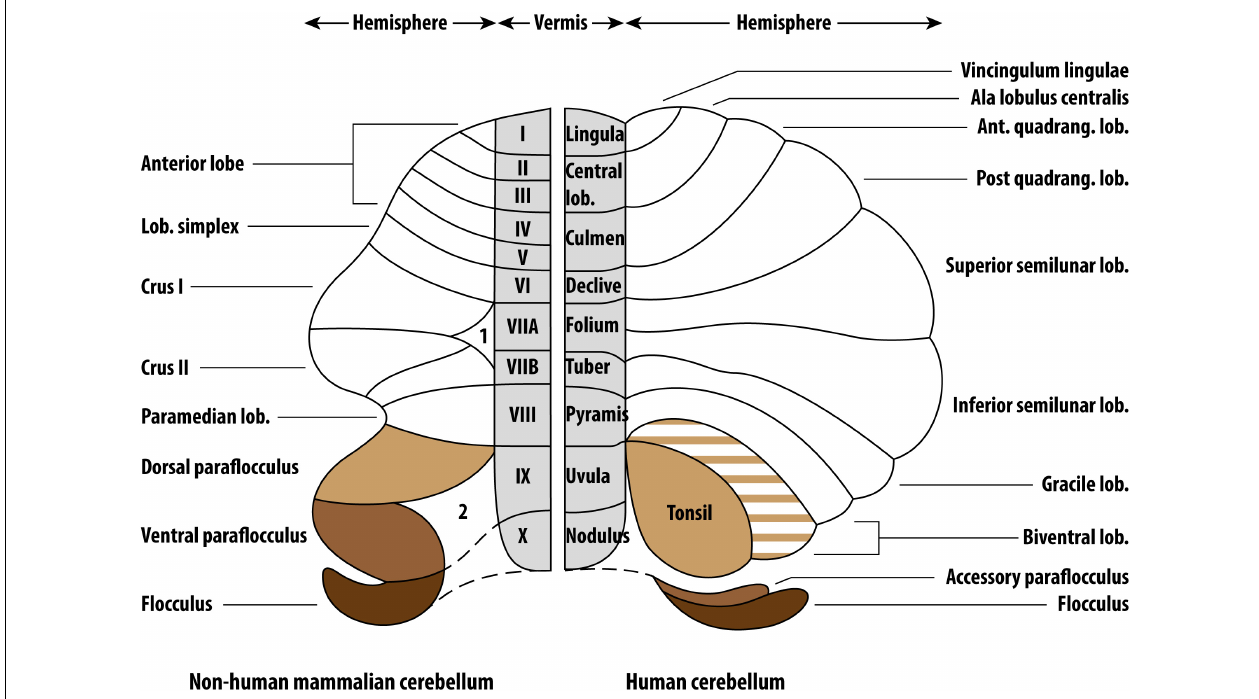
FIGURE 1 | Comparative anatomy of the non-human mammalian and human cerebelli. The non-human mammalian FL, ventral PFL and dorsal PFL are the parallels of the human FL, accessory PFL and cerebellar tonsil, respectively. Figure reproduced from Mennink et al. (2020) (CC BY 4.0).